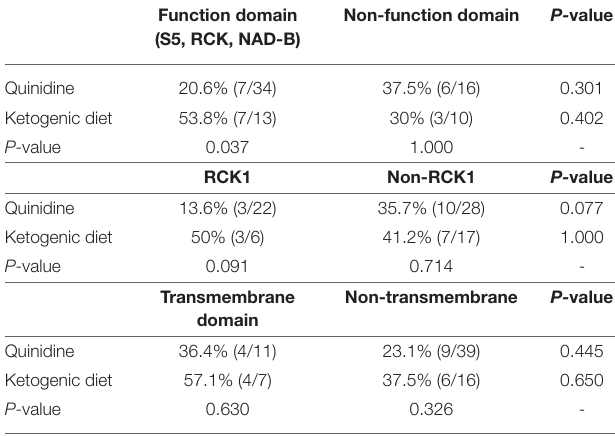
TABLE 3 | Efficacy of quinidine and ketogenic diet in the treatment of KCNT1-related